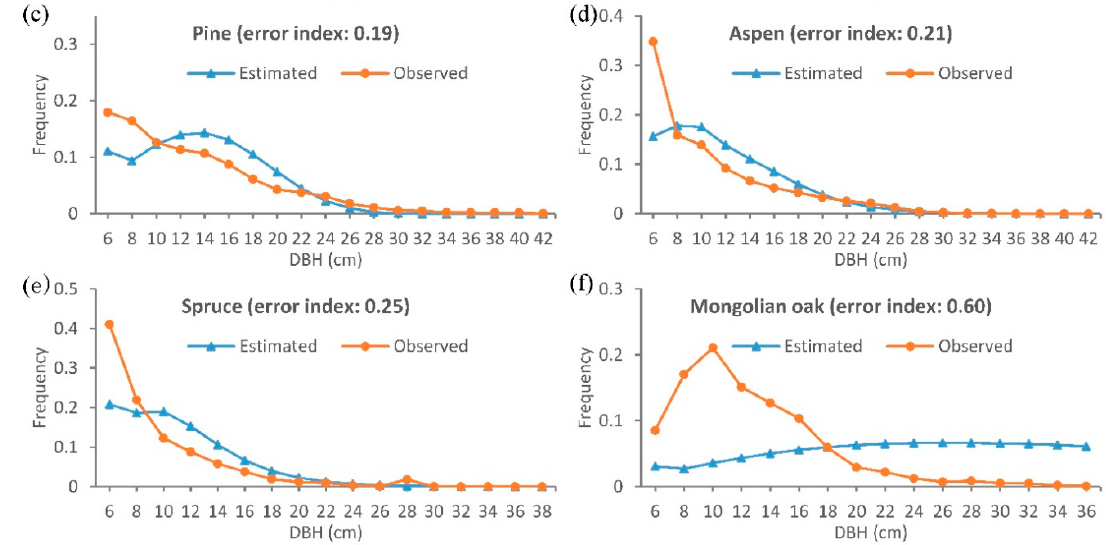
Figure 7. DBH distributions by species (larch ( a ), white birch ( b ), pine ( c ), aspen ( d ), spruce ( e ), Mongolian oak ( f )) of the observed vs. estimated wall-to-wall tree-lists based on the transformed inventory tree-lists data. The error indices were calculated by regarding all transformed plots as a whole.